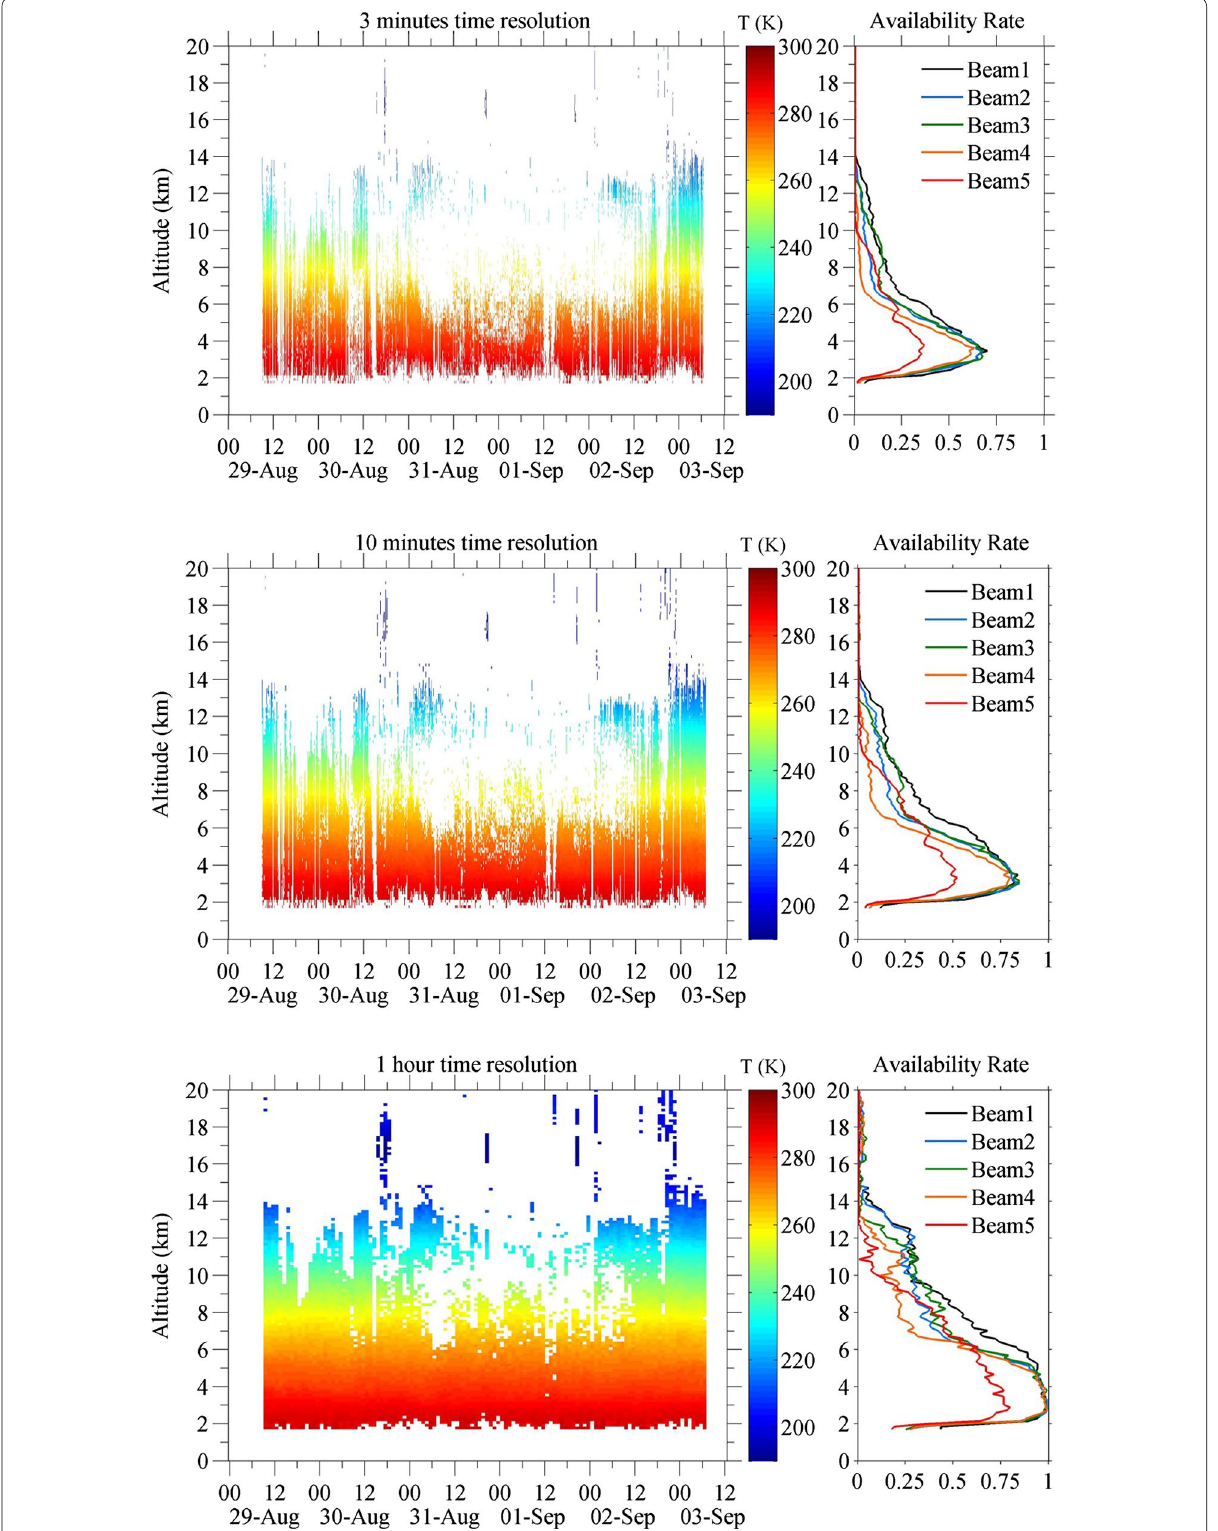
Fig. 14 Time and height plots of T (left) and the data availability rate (right) for the original RASS data with 3-min resolution (top) and averaged results with 10 min (middle) and 1 h (bottom)